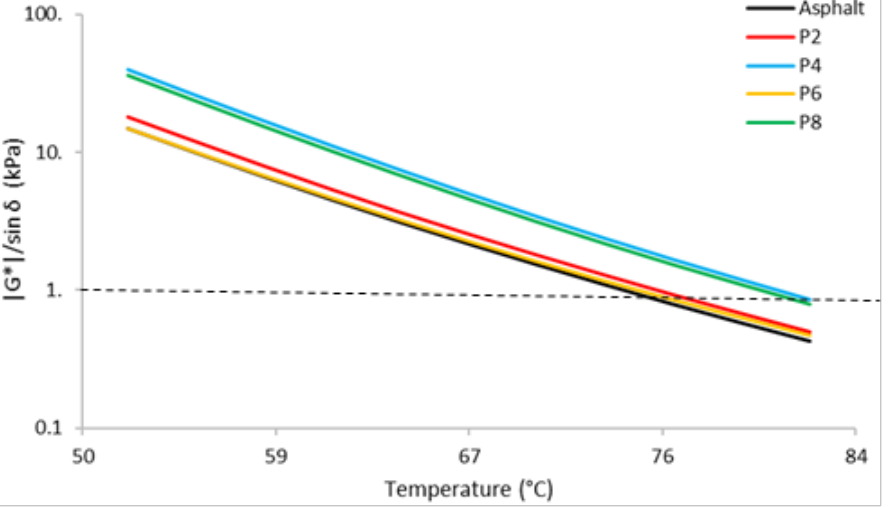
Figure 4. Isochronal plots of |G*|/sin δ vs. temperature of asphalt modified by pistachio seed shell particles.